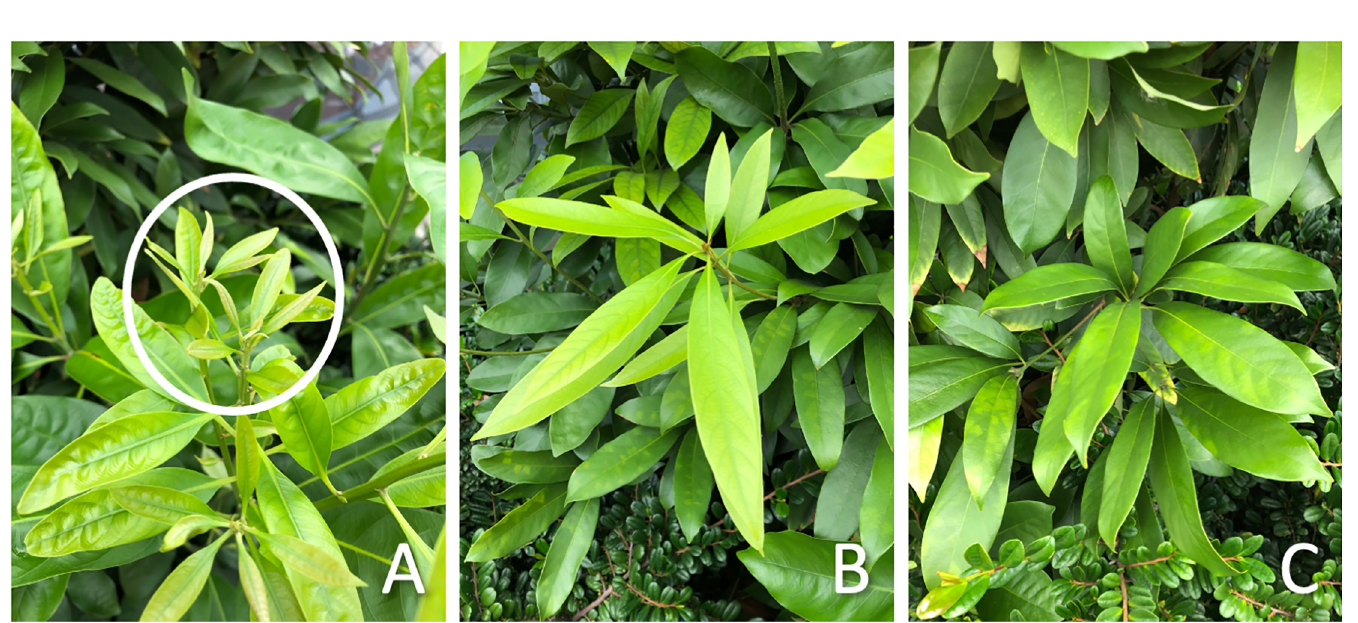
Fig 3. Leaf stages of L . edulis . (A) Young emerging leaves, (B) young fully expanded leaves, and (C) mature leaves.